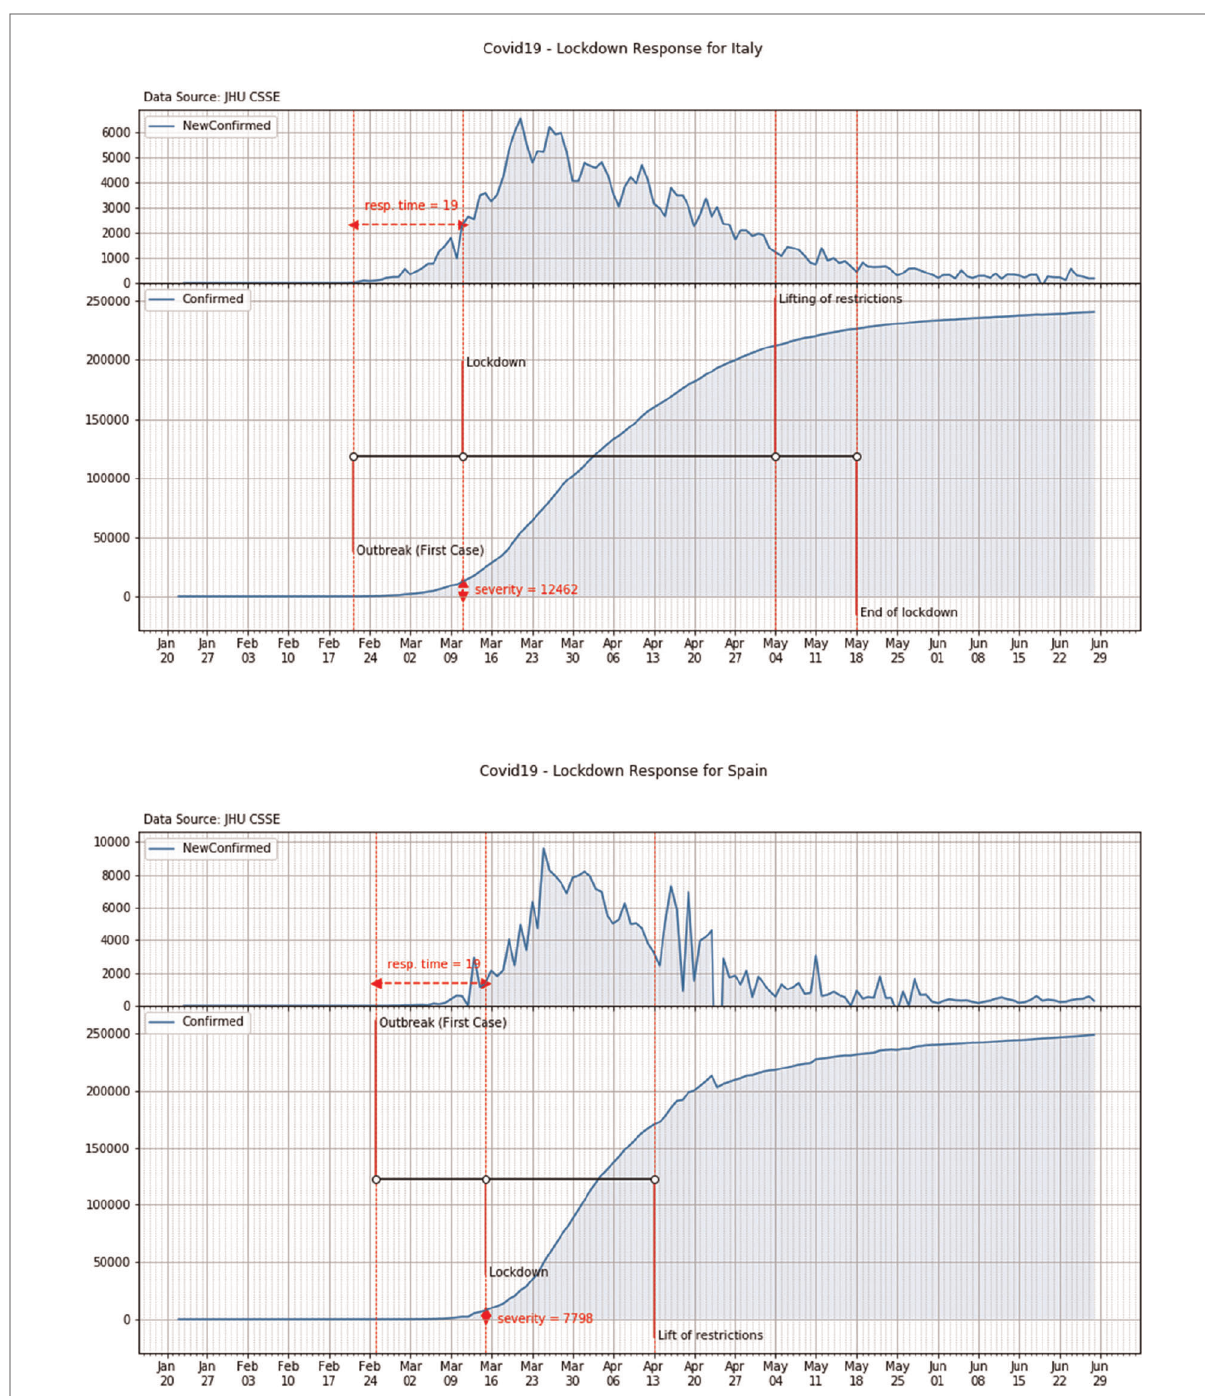
FIGURE 6 Response time and severity of the lockdown in Italy (top panel) and Spain (bottom